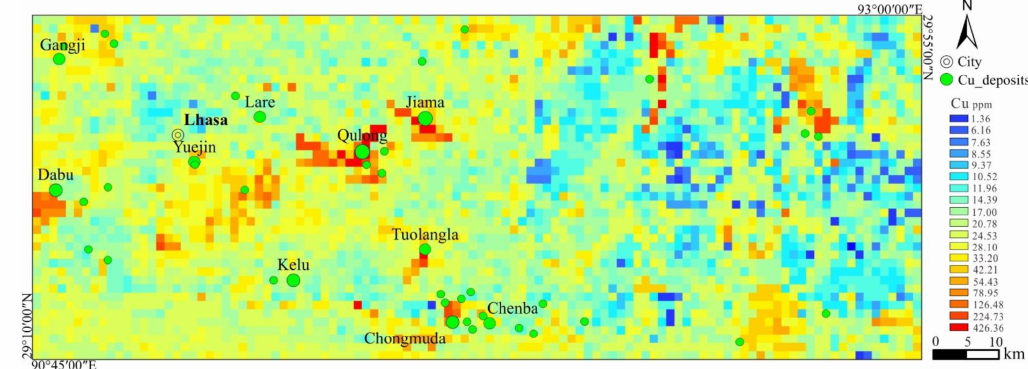
Figure 5. The realization of Cu: the study area is divided into 108 × 41 grids with a grid size of 2 km × 2